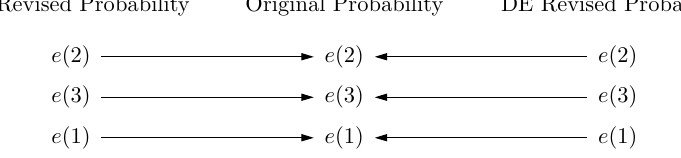
Figure 3: Comparison of expected impact ranking order for a 3 × 3 system.